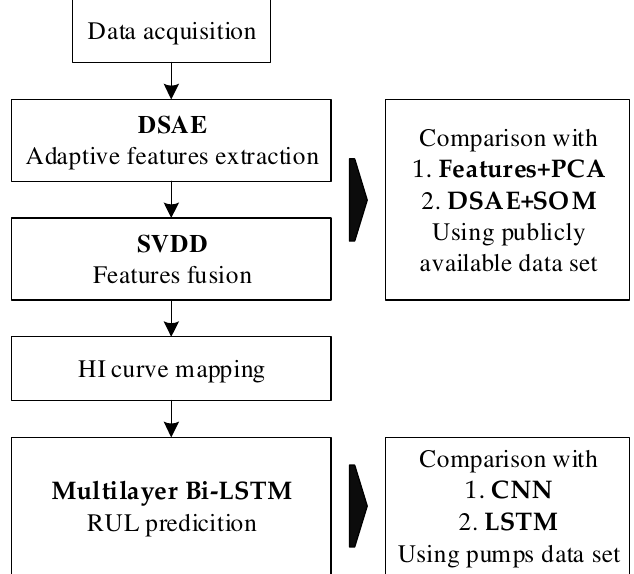
Figure 8. The flow chart of this section.